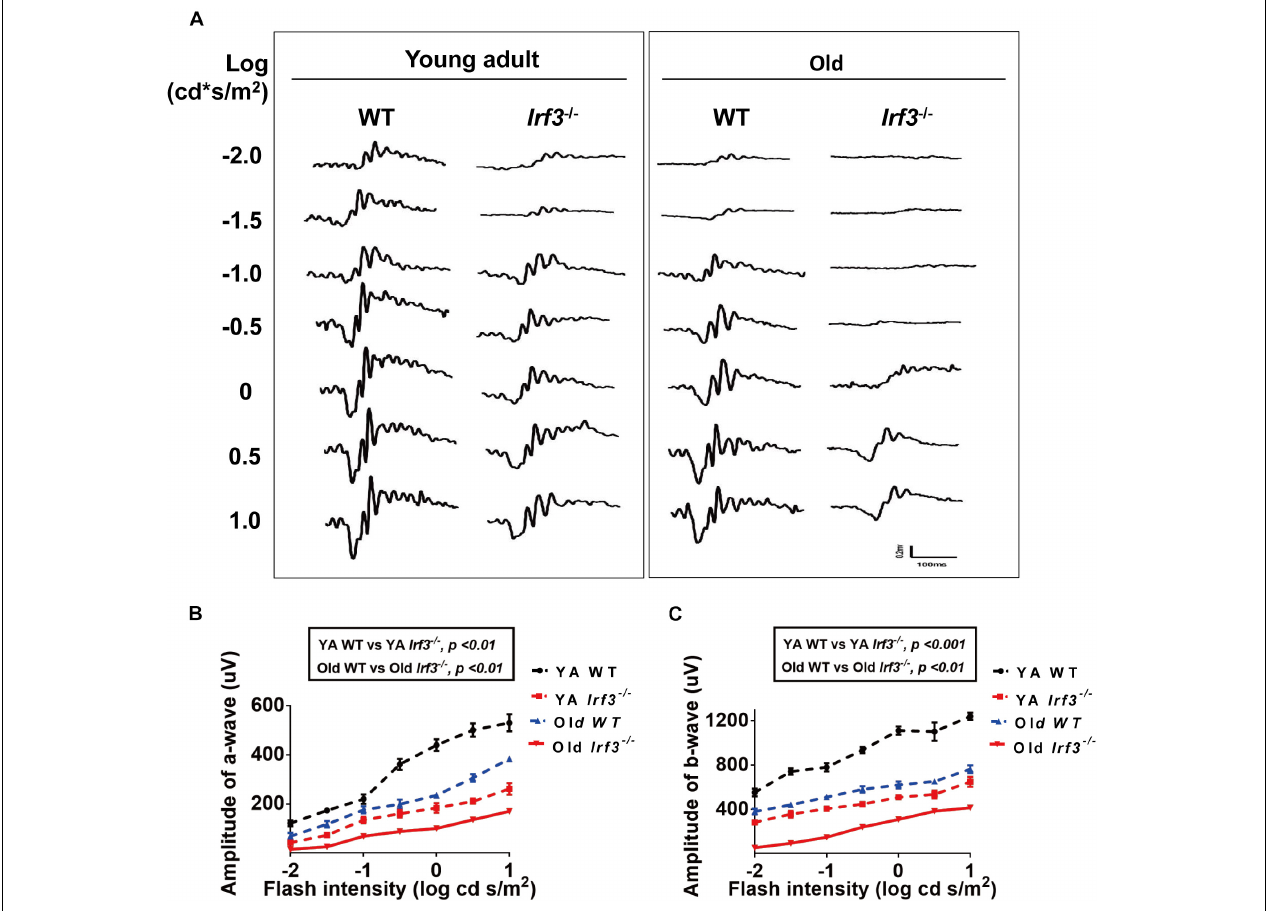
FIGURE 2 | IRF3 deficiency causes abnormal physiological function of the retina. (A) Analysis of ERG a- and b-wave responses in both YA and old WT and Irf3 − / − mice. Representative scotopic ERG recordings evoked by white light flashes of increasing intensities; traces on the left-side of the figure are shown as the log intensity (log cd s/m 2 ). (B,C) Quantification of ERG amplitudes in a- and b-waves of dark-adapted mice in each experimental group. a-wave amplitudes (B) and b-wave amplitudes (C) measured from recordings of dark-adapted YA and old WT and Irf3 − / − mice. The amplitudes of a- and b-waves in Irf3 − / − mice were significantly different from those in WT mice of the same age. Data are presented the mean ± SEM (a-wave: p < 0.001, b-wave: p < 0.001; n = 9 per